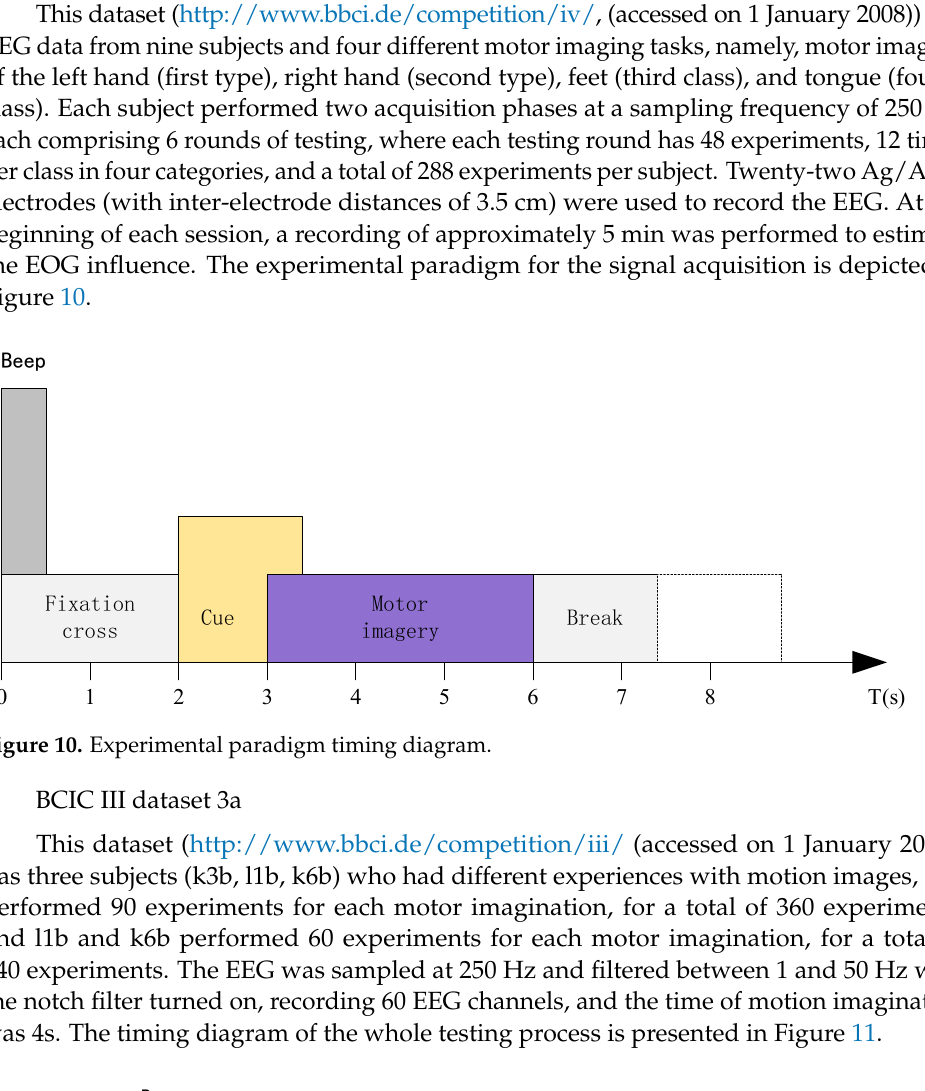
Figure 9. Feedback motion imagination with recognition results.